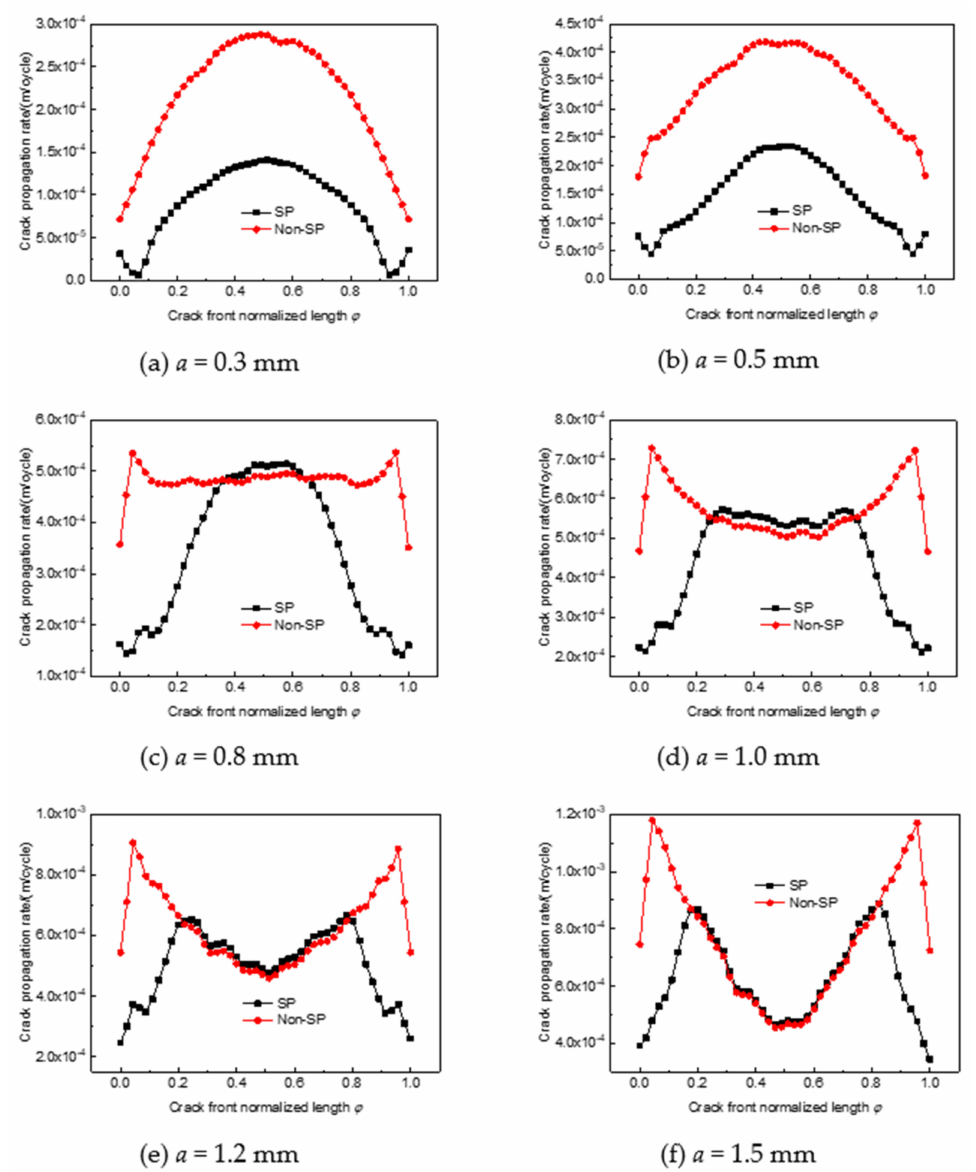
Figure 6. Crack front extension rate for peened and non-shot-peened parts. ( a ) a = 0.3 mm; ( b ) a = 0.5 mm; ( c ) a = 0.8 mm; ( d ) a = 1.0 mm; ( e ) a = 1.2 mm; ( f ) a = 1.5